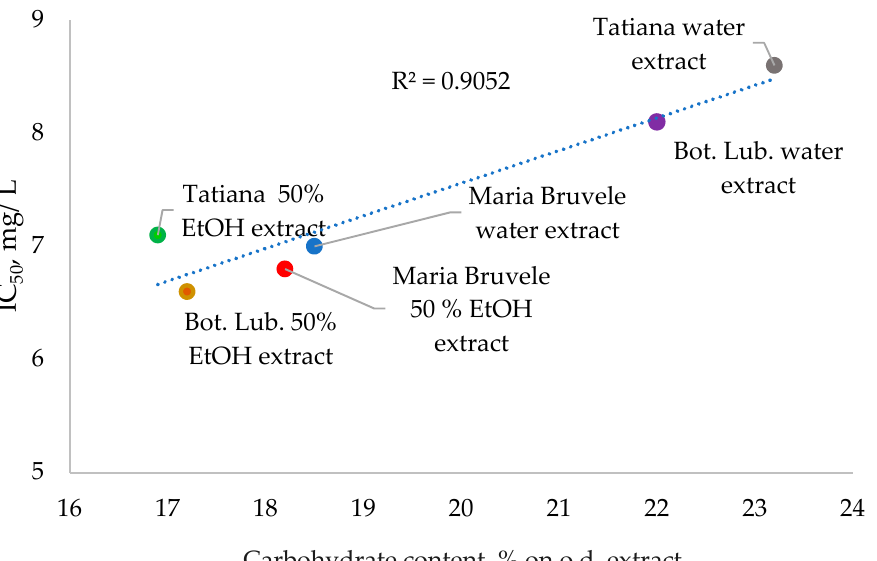
Figure 8. Effect of carbohydrate content on radical scavenging activity. Confidence intervals for antioxidant activity: CI ≤ 0.1 at α = 0.05, for carbohydrate content: CI ≤ 0.03 at α = 0.05.